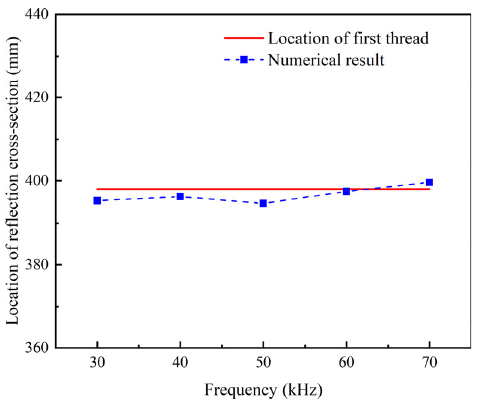
Figure 8. Location of refection cross-section under different excitation frequencies.